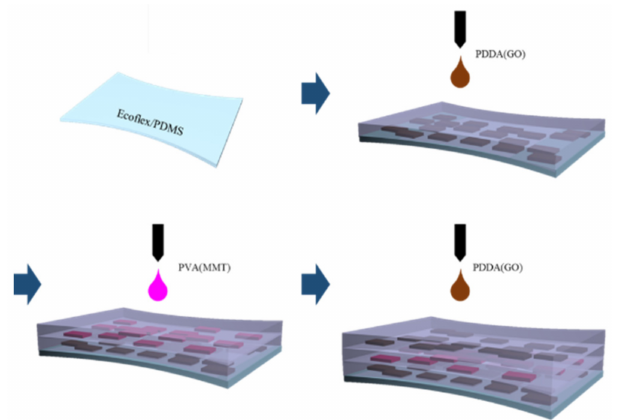
Figure 4. Schematic of the multilayered films deposited on an Ecoflex/PDMS stretchable substrate with pre-strain using LbL assembly.